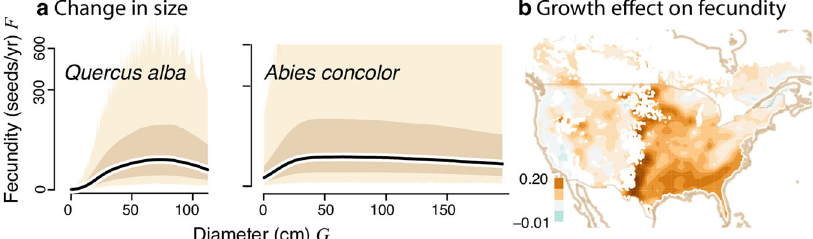
Fig. 5 Indirect effects produce an East – West contrast. a Fecundity rising then falling with size, for a common eastern hardwood ( Q. alba ) and western conifer ( A. concolor ) plotted on the square root scale. The predictive mean (black line) is bounded by the 90% credible interval (dark shading) and the 90% predictive interval (light shading) over all tree-years. b The growth effect includes terms in Eq. (1) that are multiplied by d G /d t , that is, ∂ f / ∂ G + ∂ f / ∂ ( GC ) × C (units are log f /yr). Averages shift from positive in the East to near zero or negative in the West, where more trees are near or past the diameter where growth stimulation increases